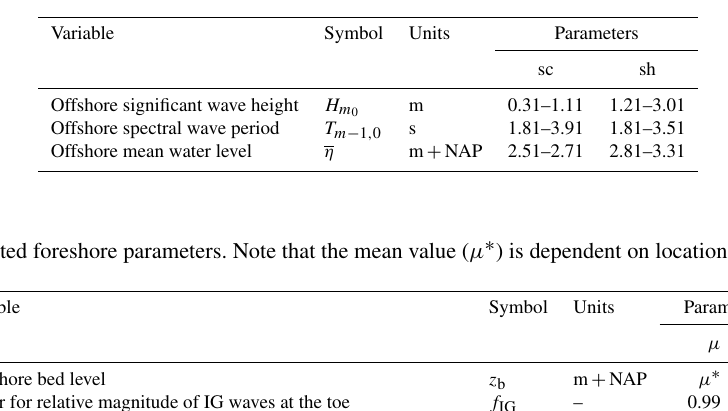
Table A1. Extreme parameters for offshore wave and water level characteristics (Weibull distributions). Note that the scale (sc) and shape (sh) parameters, derived from Hydra-NL estimates, are dependent on location along the Wadden coast; the range of values is provided here.